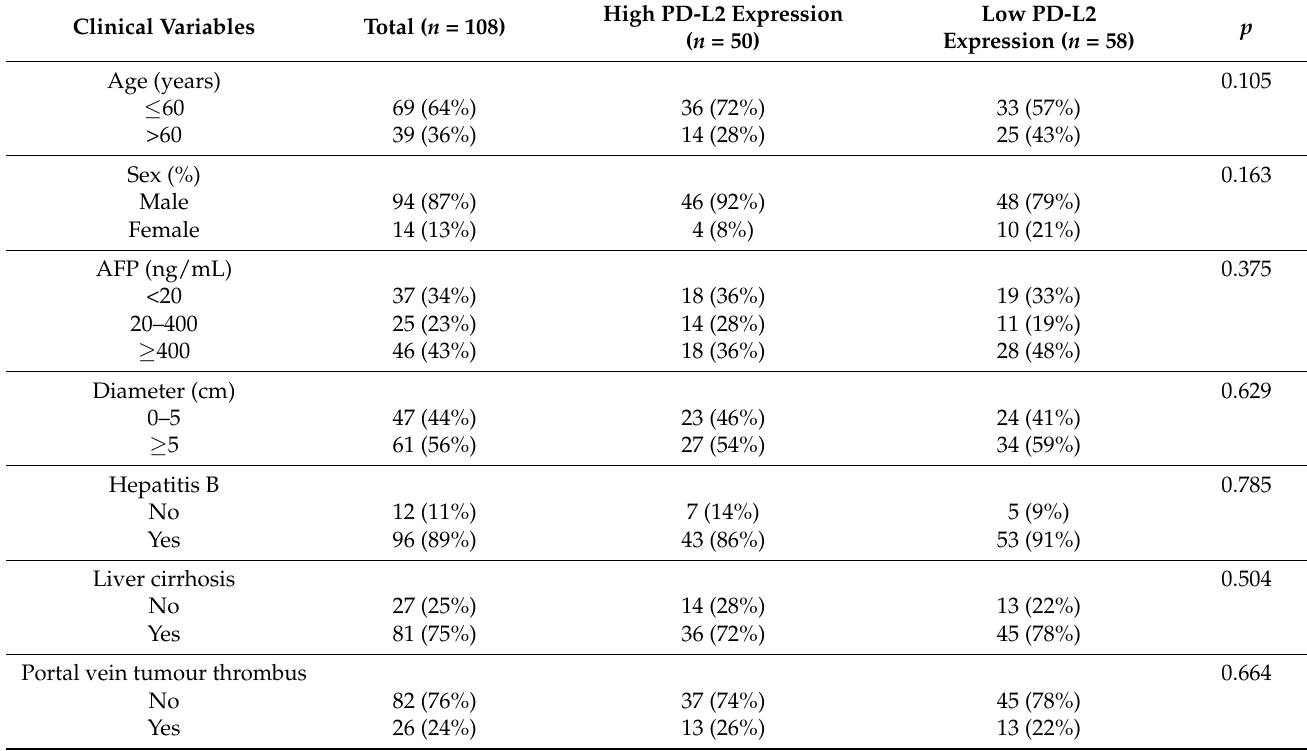
Table 2. Clinical characteristics of patients in the high and low PD-L2 expression groups.